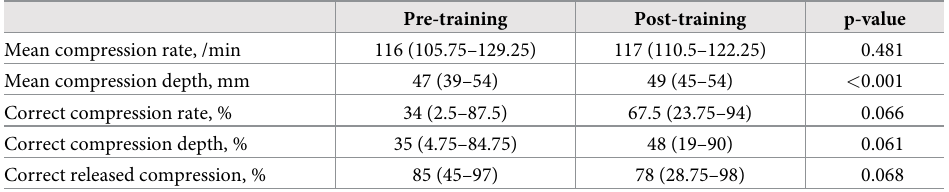
Data are shown as median (interquartile